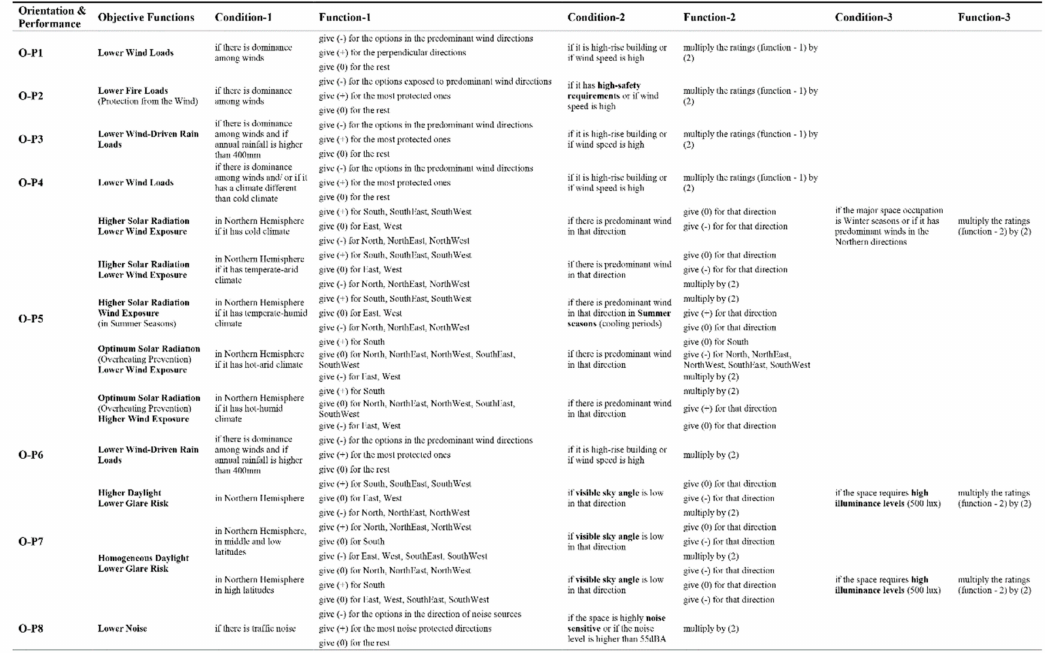
Figure A1. Ratingchartfororientation(fromthetoolprocesspages). Note: O,Orientation; P,Performance; P1, Structural P.; P2, Fire P.; P3, Water-related P.; P4, Air Permeability-related P.; P5, Thermal P.; P6, Moisture-related P.; P7, Daylighting P.; P8, Acoustic